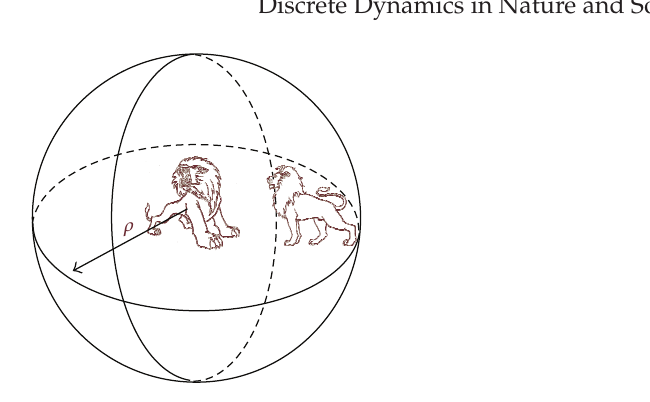
Figure 1: Dominance concept as it is presented when two animals confront each other inside of a ρ